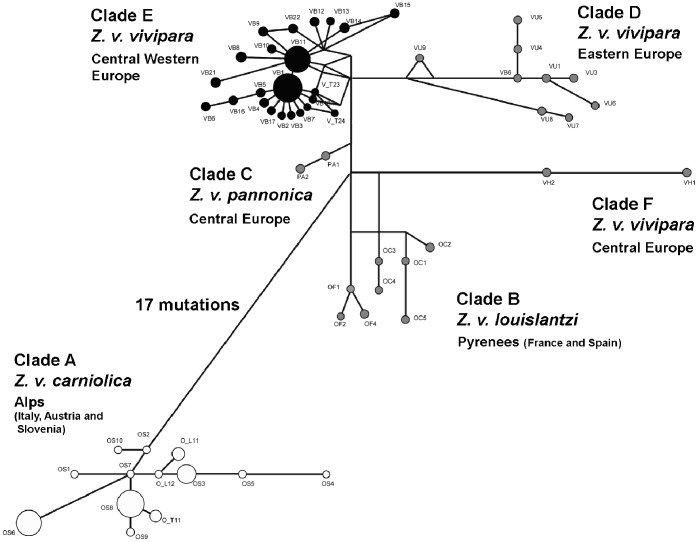
Median joining network of mtDNA cty b haplotypes.Circles represent haplotypes, area is proportional to frequency and colour indicates the subspecies (black, Z. v. vivipara; white, Z. v. carniolica; grey, other subspecies or European populations).